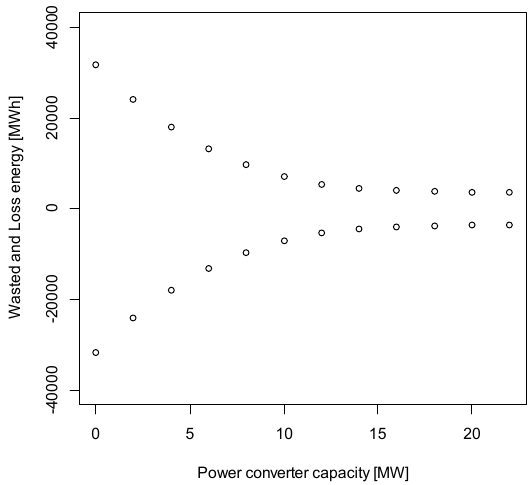
Figure 12. Evolution of wasted (U) and lost ( − L) energy according to power converter rating. There is a difference between the real values and the linear approximation presented in